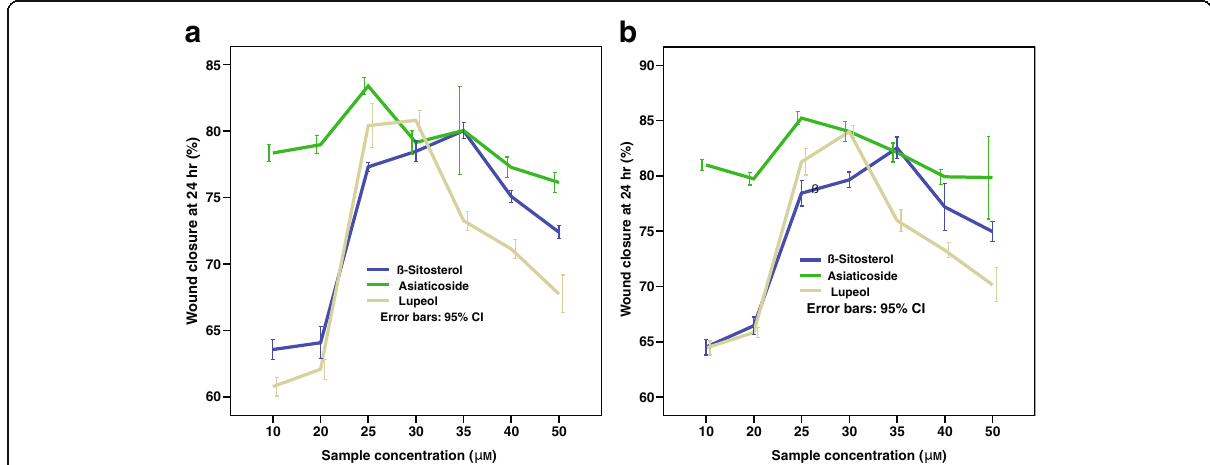
Fig. 6 Variation of percentage wound closure with concentration in the presence of lupeol ( 1 ), β -sitosterol ( 2 ) and asiaticoside (positive control) at 24 h: ( a ) BHK cell line, ( b ) MDCK cell line. (Bars represent the mean and confidence intervals of 95% of nine measurements in the three